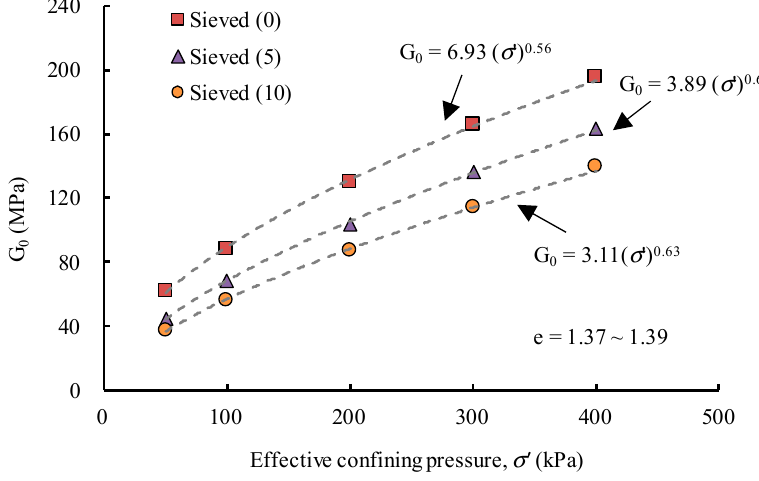
Figure 7. Small strain shear modulus (G 0 ) of the rubber–calcareous sand mixtures.